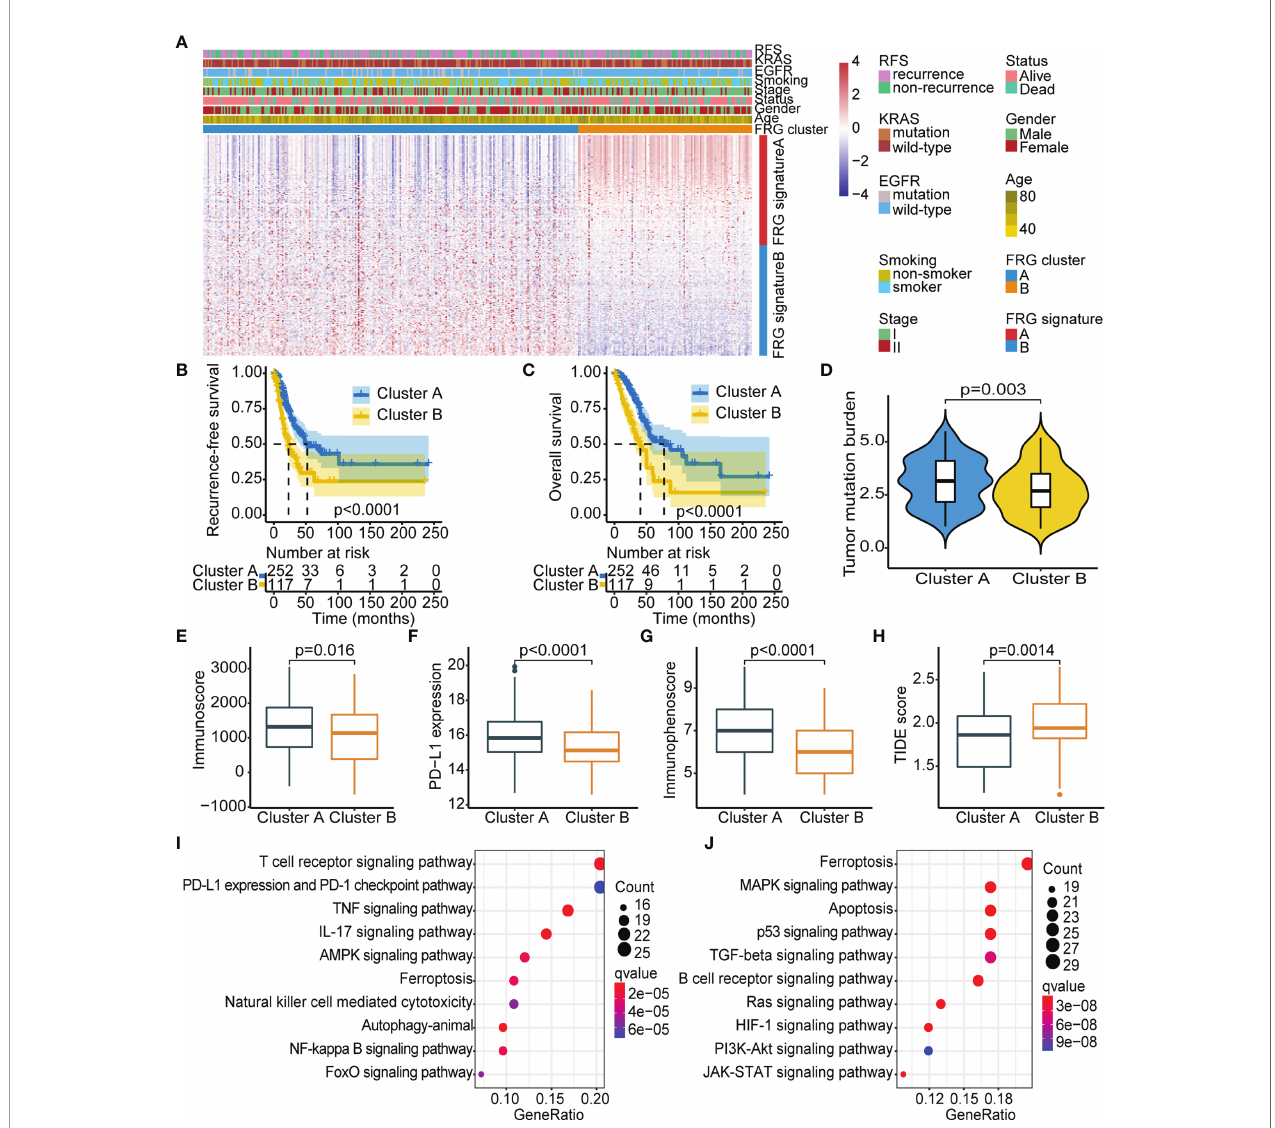
FIGURE 1 | Identi fi cation of FRG-based subtypes in early-stage LUAD. (A) Unsupervised clustering of FRGs in TCGA cohort. Clinicopathological parameters, including age, gender, stage, smoking status, EGFR/KRAS mutation status, and FRG cluster are shown. Rows represent FRGs, and columns represent samples. (B) Kaplan – Meier curves showing recurrence-free survival in the two FRG-based clusters. (C) Kaplan – Meier curves showing overall survival in the two FRG-based clusters. (D – H) Comparison of TMB (D) , immunoscore (E) , PD-L1 expression (F) , immunophenoscore (G) , and TIDE score (H) between the two FRG clusters. (I, J) KEGG analysis of the two FRG cluster-related signatures: FRG signature A (I) and FRG signature B (J) . FRG, ferroptosis-related gene; LUAD, lung adenocarcinoma; TCGA, The Cancer Genome Atlas; EGFR, epidermal growth factor receptor; TMB, tumor mutational burden; TIDE, Tumor Immune Dysfunction and Exclusion; KEGG, Kyoto Encyclopedia of Genes and